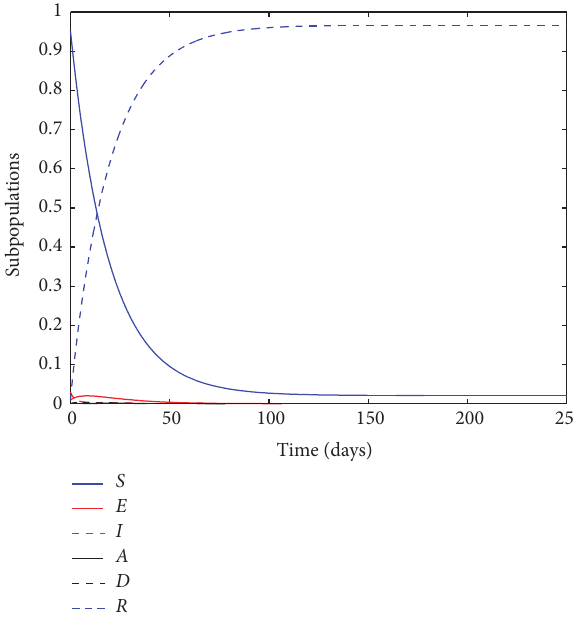
Figure 20: Evolution of the subpopulations with daily culling rate of = 0.1 , feedback vaccination 𝑉 = 0.2𝑏 𝜌 𝐷 treatment 𝜉(𝑡) = 𝐾 𝜉 𝐼(𝑡) = 0.01𝐼(𝑡)